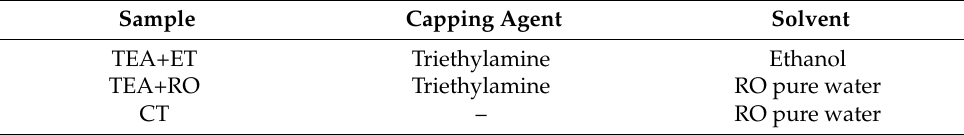
Table 1. Process differences of samples prepared via different preparation methods. (Triethylamine is abbreviated as TEA and anhydrous ethanol is abbreviated as ET, reverse osmosis pure water is abbreviated to RO. The sample which was prepared in RO pure water, but TEA was not added, is abbreviated to CT.). Sample Capping Agent Solvent TEA+ET Triethylamine Ethanol TEA+RO Triethylamine RO pure water CT – RO pure